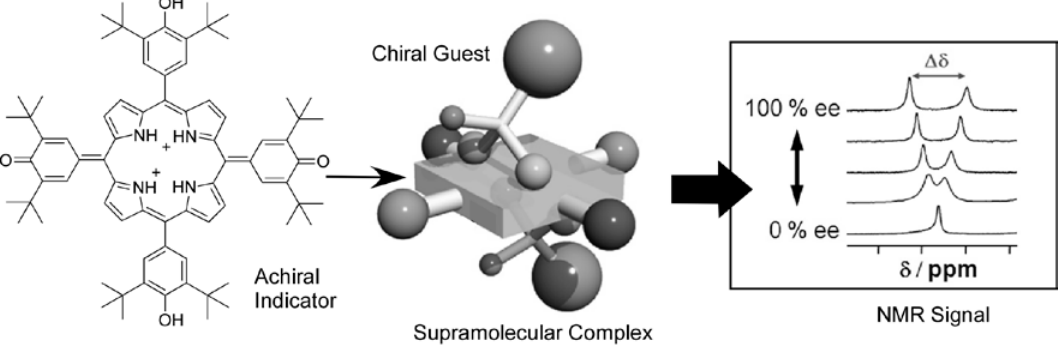
Figure 5. Quantification of enantiomeric excess of chiral guests by nonchiroptical spectroscopy, NMR, with achiral additives through supramolecular complex